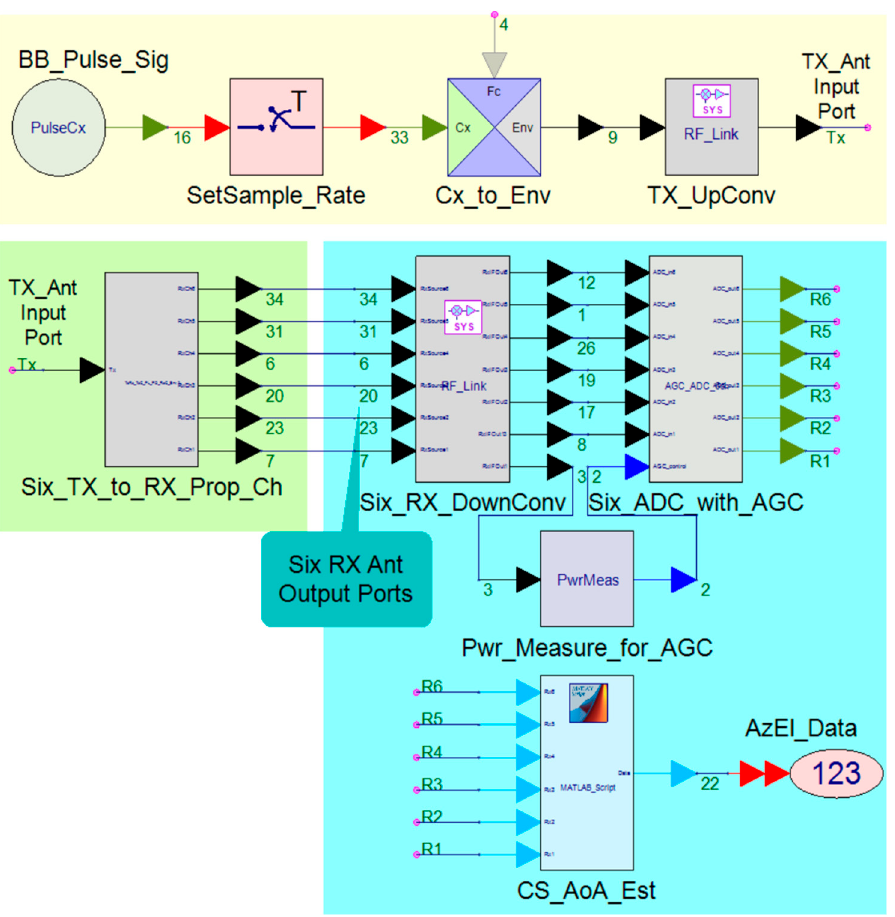
Figure 11. The top-level SVE model for the RESM system to estimate of the TAR signal